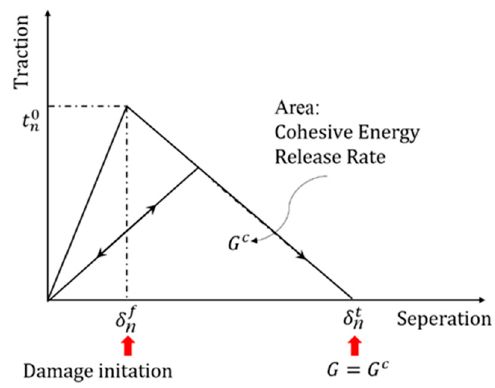
Figure 4. Cohesive linear-softening for the Benzeggagh–Kenane (BK) criterion.